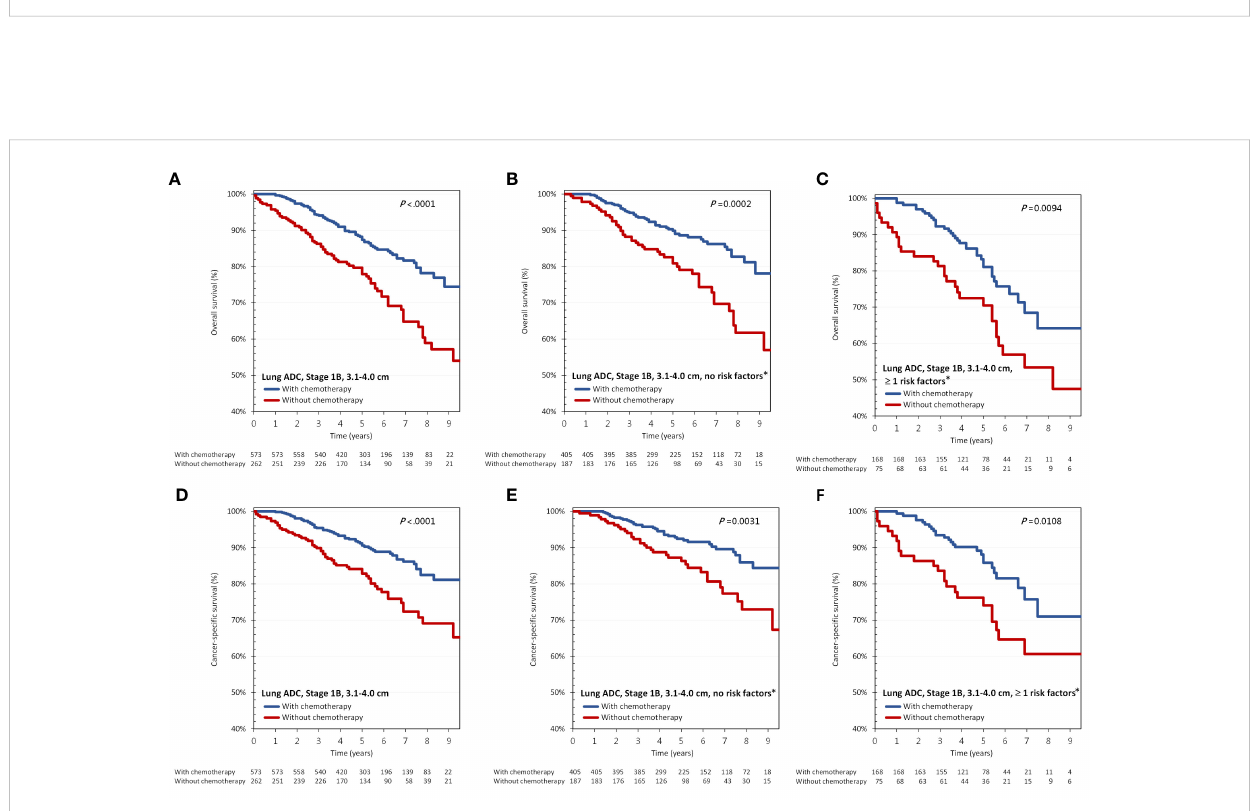
FIGURE 4 (A – C) overall survival and (D – F) cancer-speci fi c survival according to the administration of adjuvant chemotherapy and presence of risk factors in group 2: tumor >3 cm, but <=4 cm. ADC, adenocarcinoma. *The risk factor in group 2 refers to having either high-grade histologic fi ndings or receiving sublobar